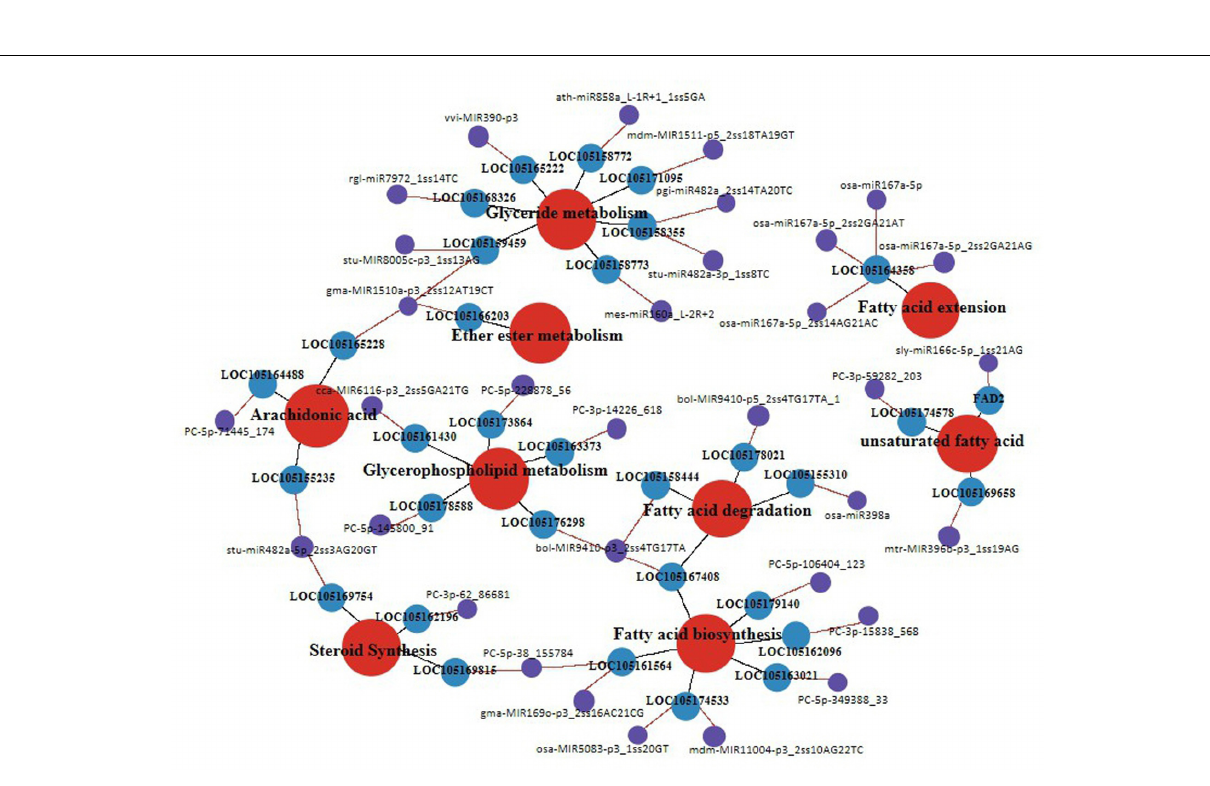
Frontiers in Plant Science |